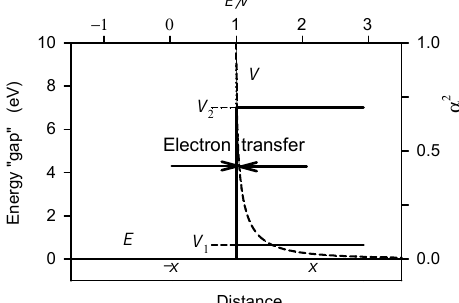
Figure 6. Infinitely wide one-dimensional potential barrier with energy gaps whose potentials correspond to germanium ( V 1 ) and diamond ( V 2 ), i.e., to a semiconductor and an insulator, respectively. The dashed line denotes the reflection coefficient α 2 (probability of reflection) for particles with an energy higher than the potential of the barrier (after Dicke and Wittke [47]).